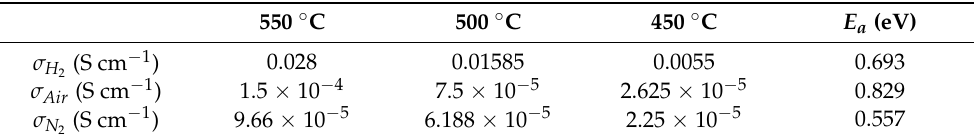
Figure 6. The electrical conductivity of 5LZO-5SDC at 450–550 ◦ C acquired in air, nitrogen, and hydrogen atmospheres. Table 3. The DC electrical conductivities of 5LZO-5SDC at 450–550 ◦ C in ambient air, pure nitrogen, and pure hydrogen, and the corresponding activation